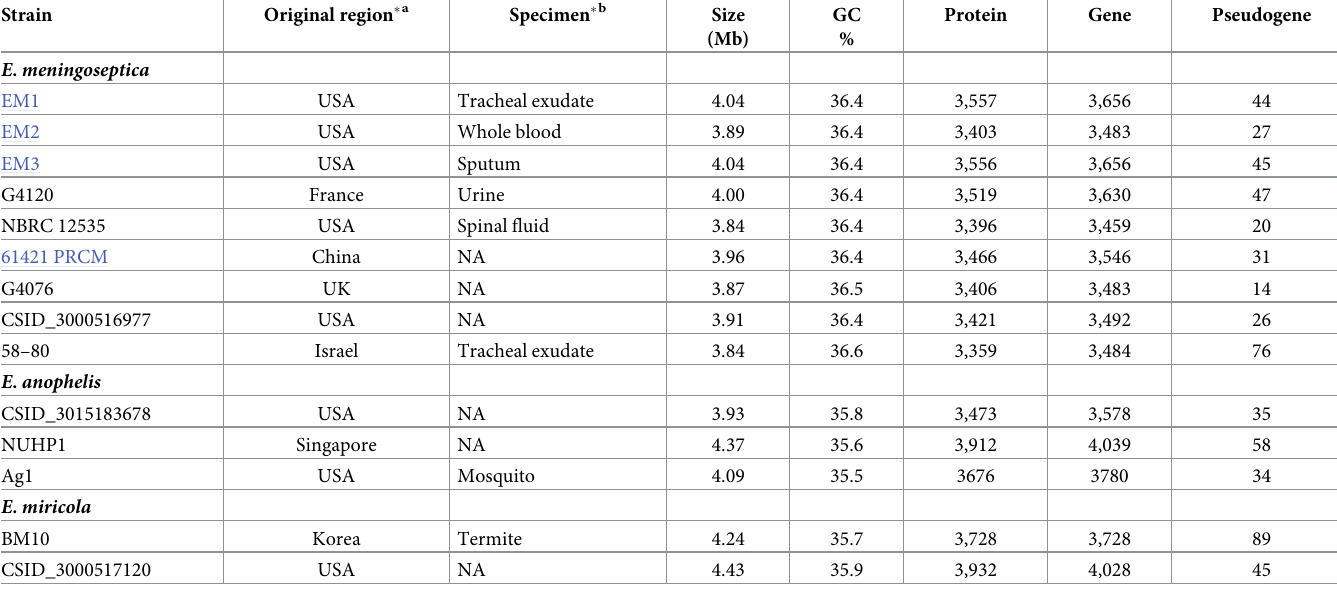
Table 1. General features of selected Elizabethkingia genomes.